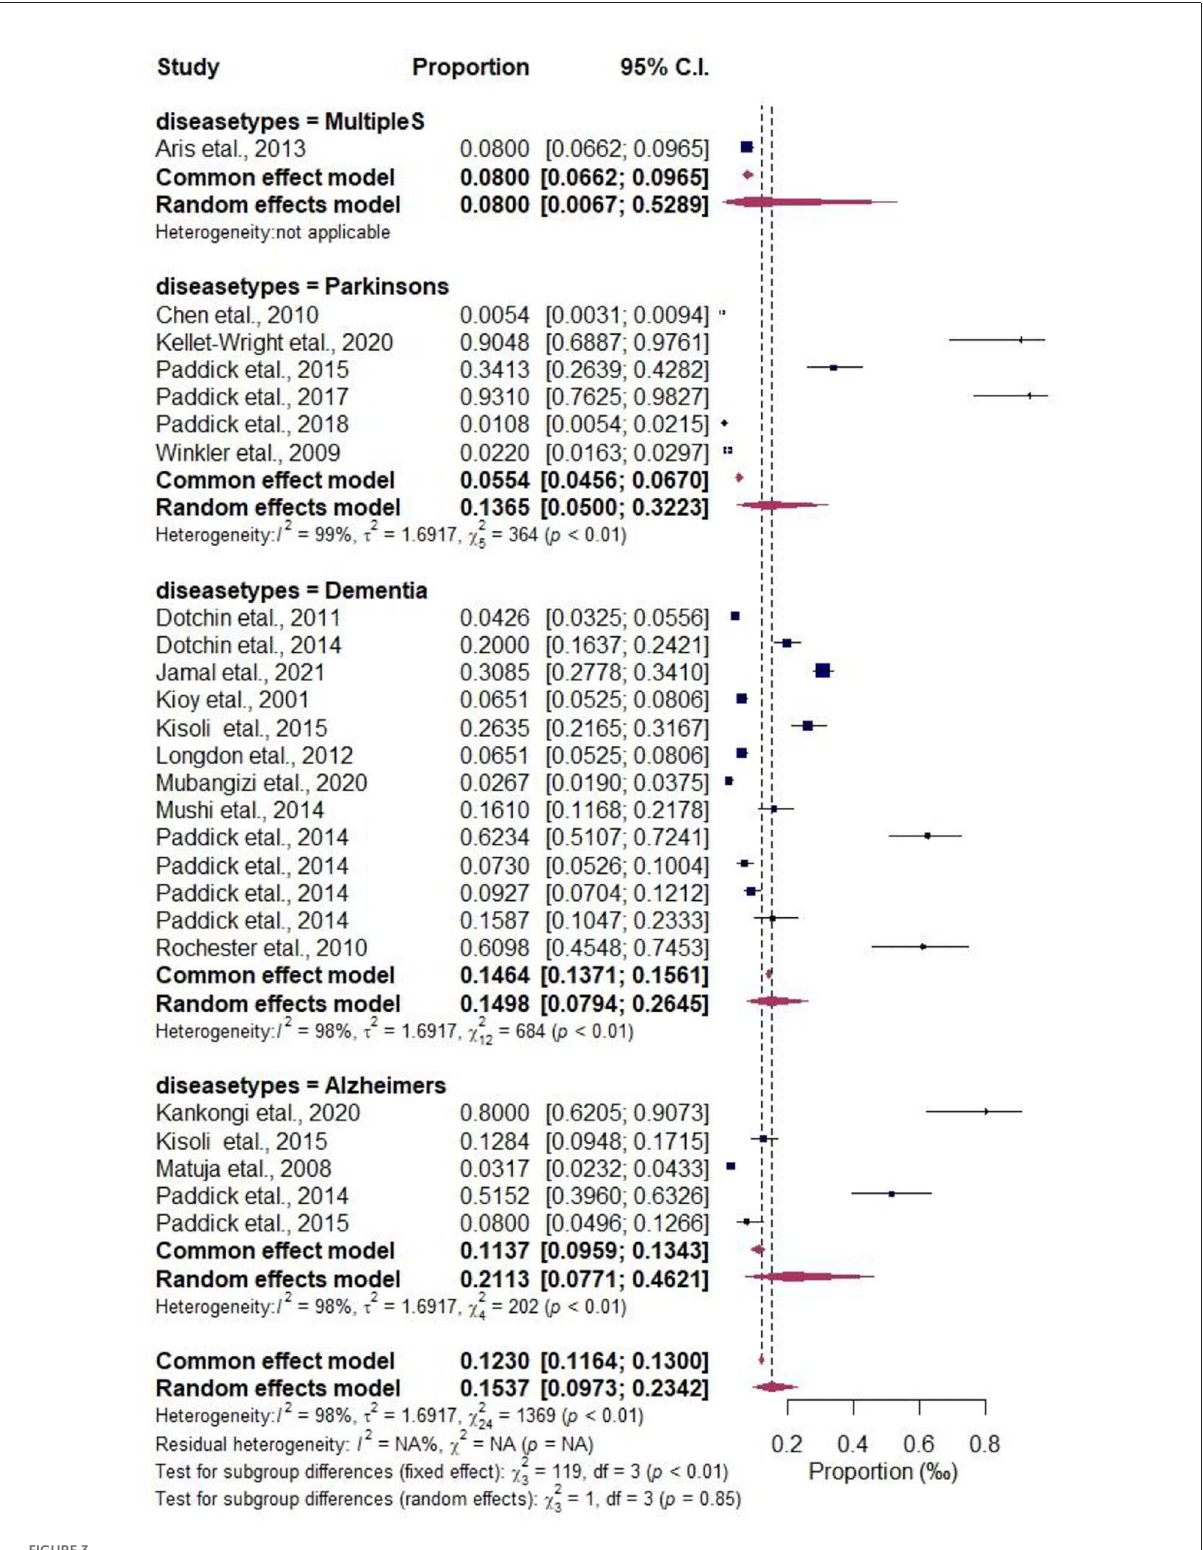
FIGURE3 Forest plot of the subgroup analysis by NDs